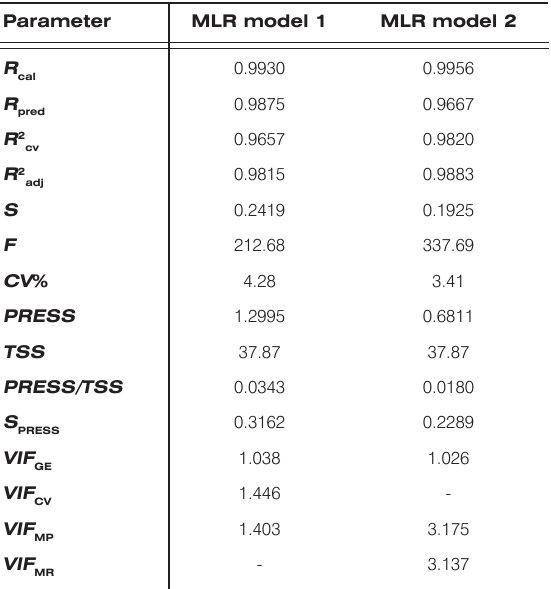
Table 2. Statistical parameters of MLR models established.